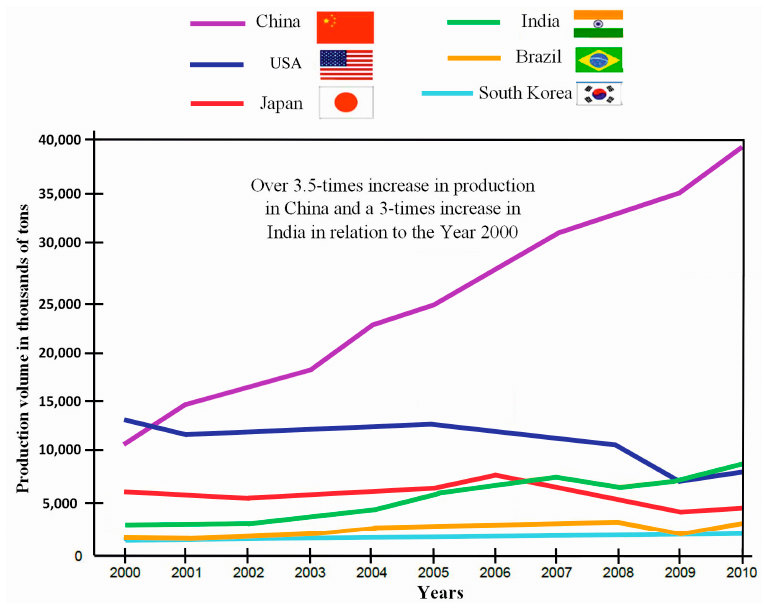
Figure 1. Global trend in the production of castings of major producers in the years 2002–2011